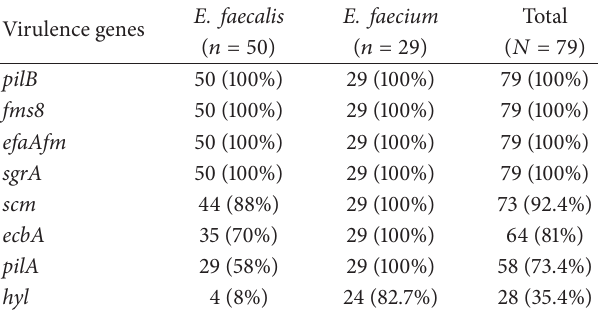
Table2:Distributionofdifferentvirulencefactorsin E. faecium and